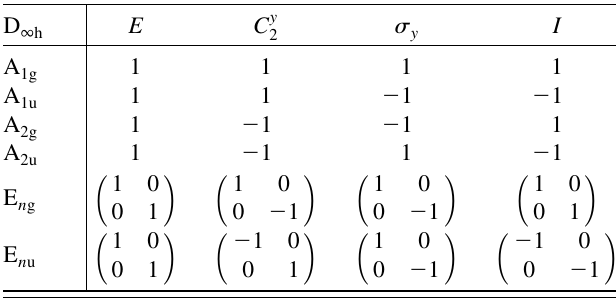
. The matrices for the operation C y 2h (cid:3) I(cid:23) . y 2